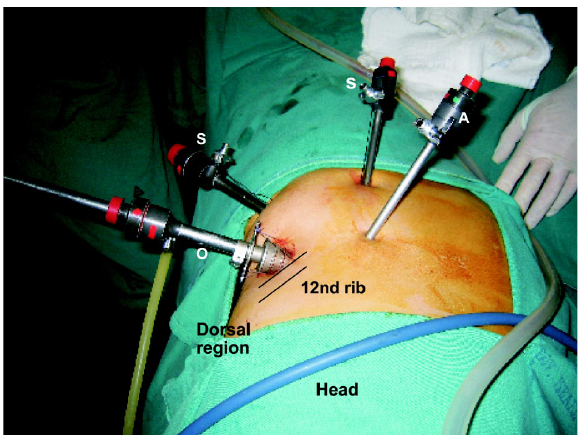
Figure 1 – Upper view of a patient in right lateral decubitus showing the location of the ports (S = surgeon, A = assistant, O =